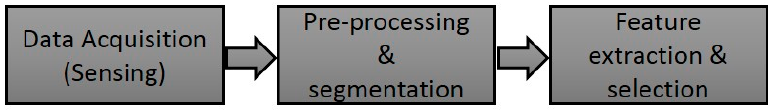
Figure 5. Block diagram of the data pre-processing used.